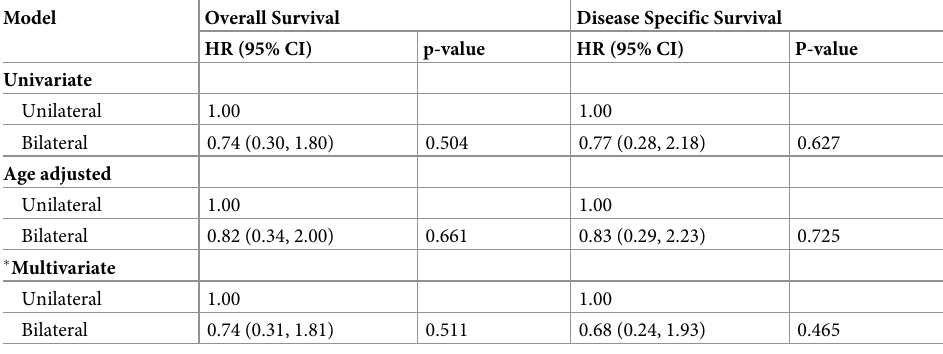
Table 3. Cox proportional hazard ratio models for overall and disease free survival in patients with squamous cell carcinoma of the head and neck from an unknown primary (n =